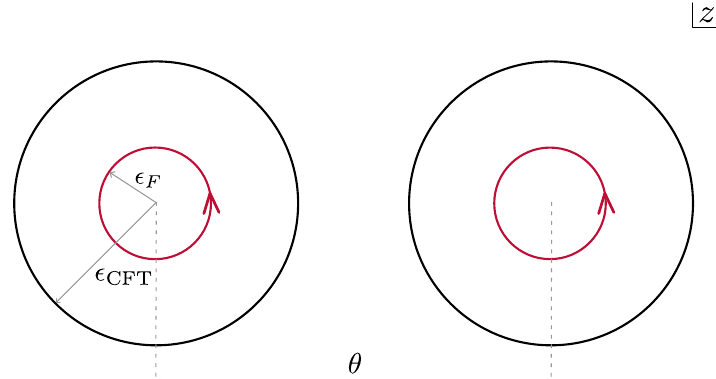
are F represent the CFT cutoff. The CFT